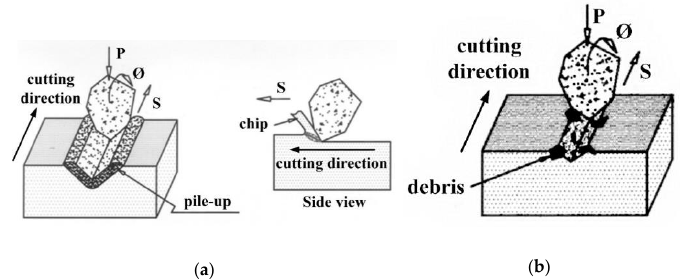
Figure 1. Illustration of wire-sawing: ( a ) fine chips removed by plastic deformation; ( b ) debris generated by brittle fracture.